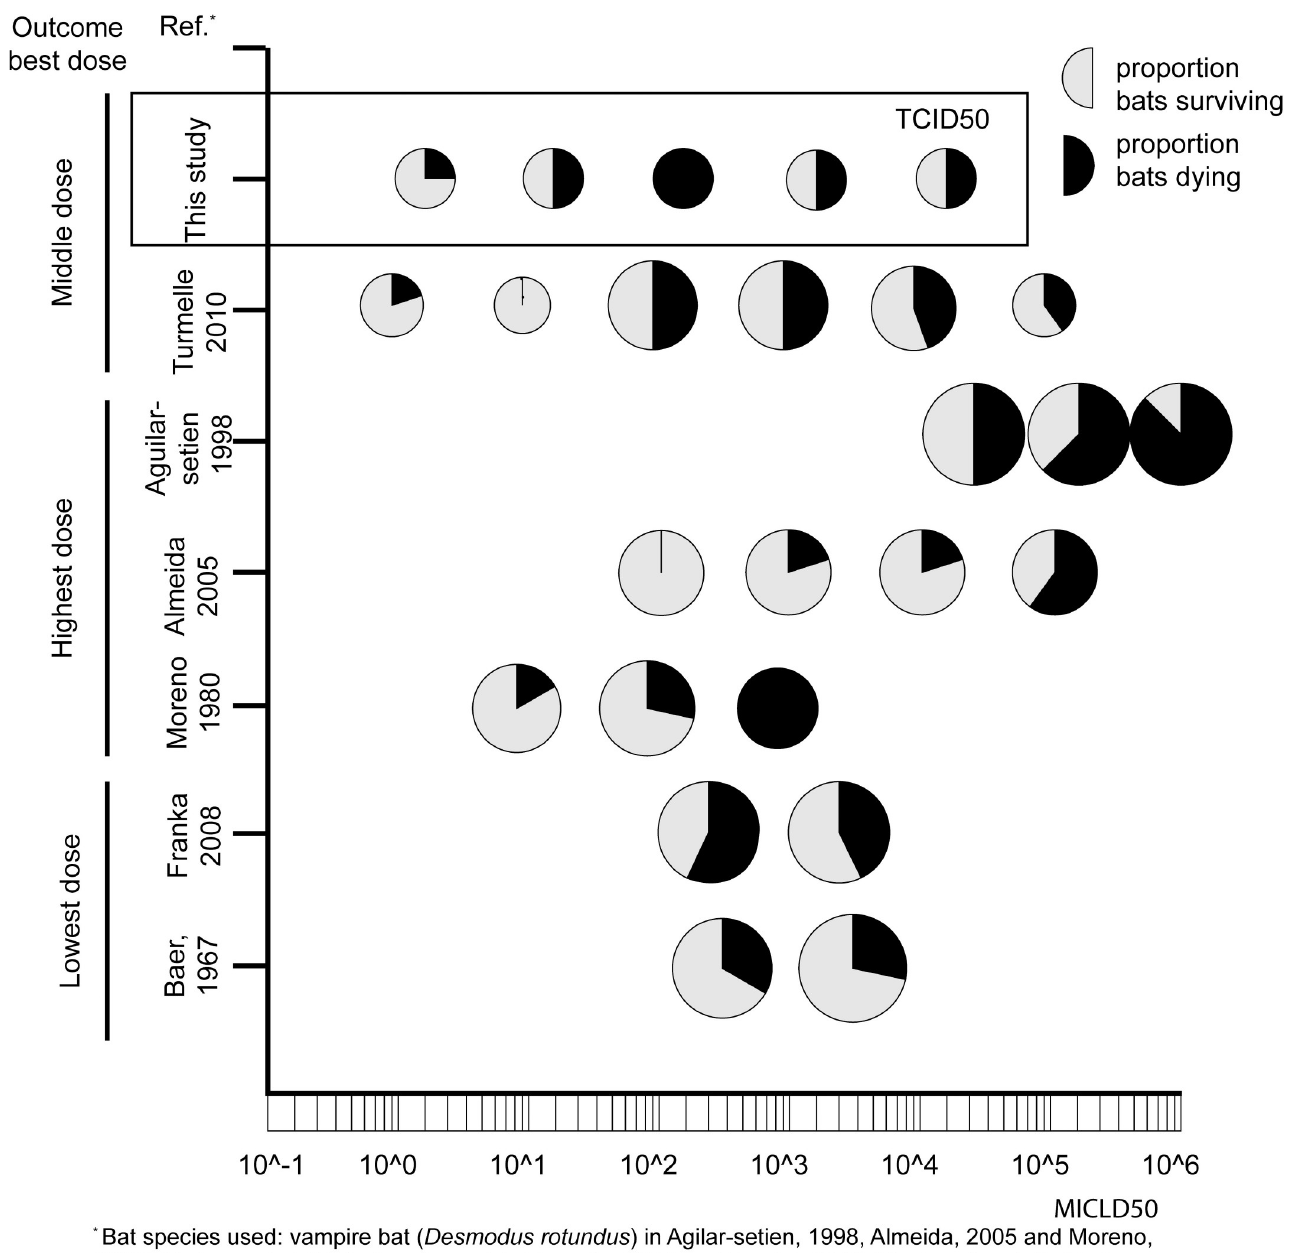
Fig 4. Schematic overview of mortality and survival of bats in published experiments that used different lyssavirus doses, compared to the results of this study. Only studies conducted since 1960 and experiments using intramuscular inoculation routes are included. Each circle is a group inoculated with a certain dose. The size of the circle indicates the number of animals included in the group. Black indicates ratio bats in the group that died due to infection, grey means ratio that survived. Published experiments used rabies virus, our study used Lagos bat